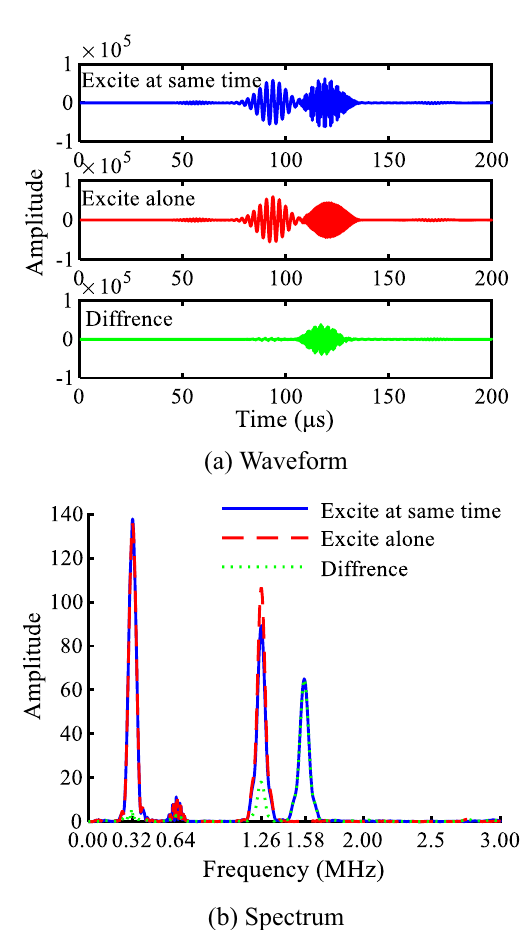
Figure 7 Results received at point 2 under different